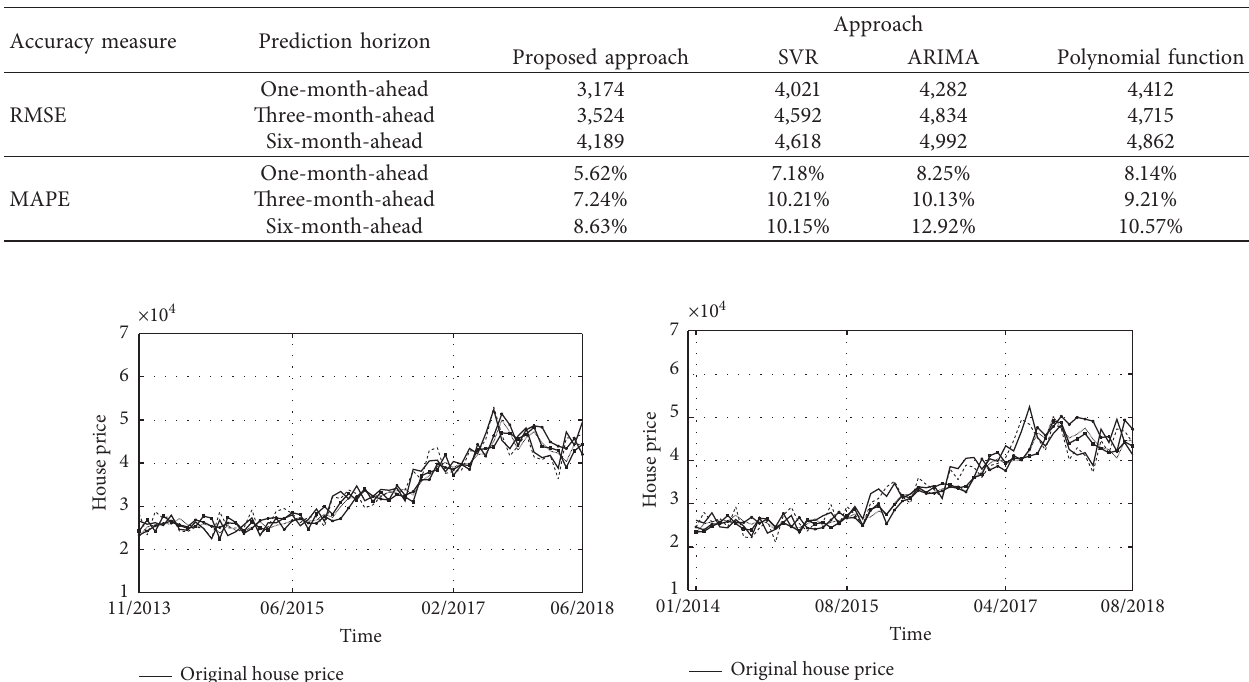
Table 7: The forecasting performance of the proposed approach and three alternatives.